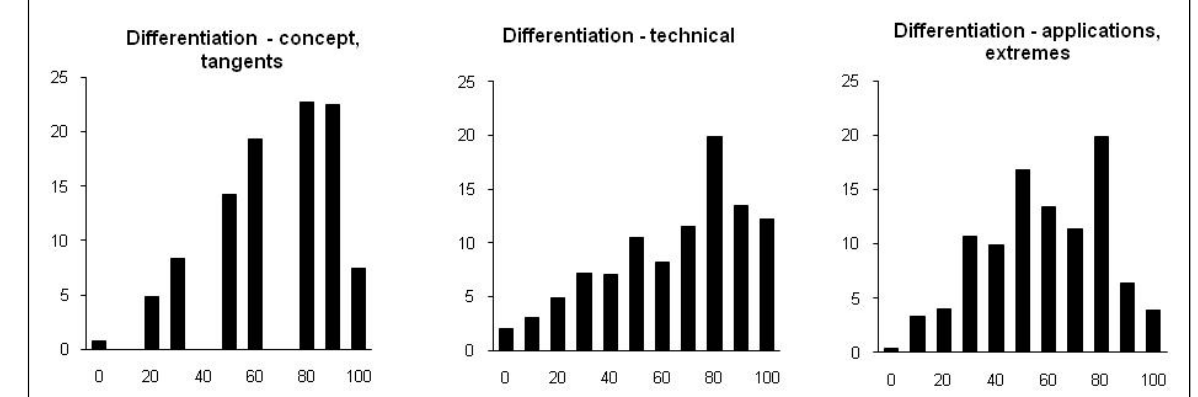
Figure 10 : Student performance in differentiation in Semester Test